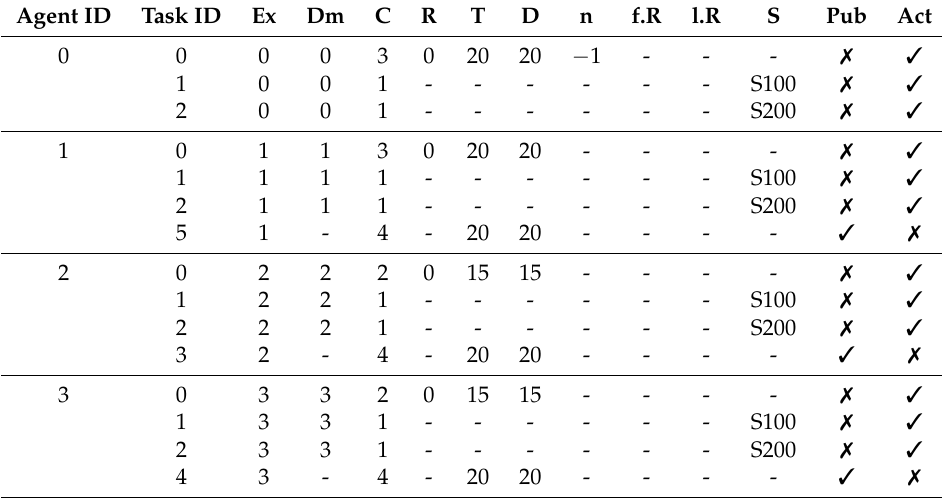
Table 4. Agents’ task-set for Scenario S1.